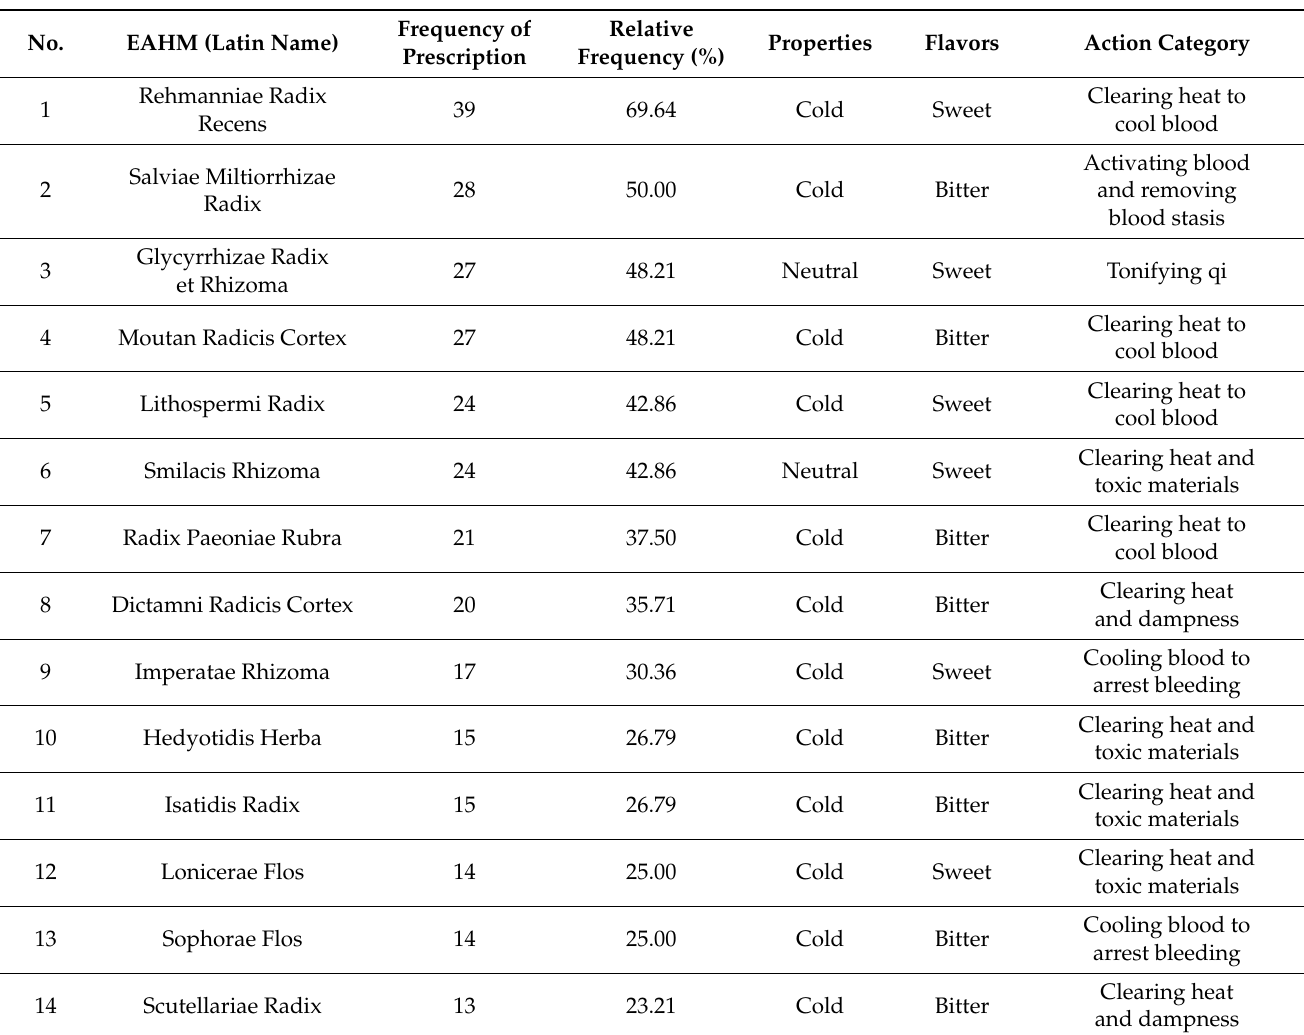
Table 6. Characters of top 16 commonly prescribed herbs utilized with relative frequencies exceeding 20% inclusion